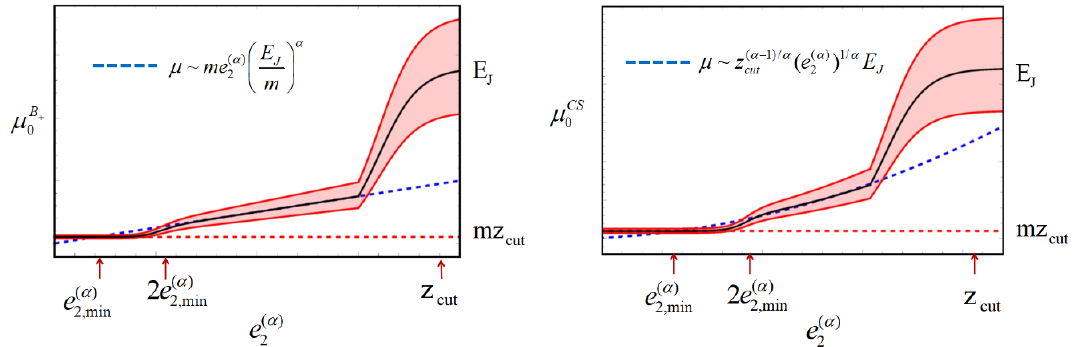
Figure 9 . Pro(cid:12)les in the renormalization scales for the bHQET jet (left) and the collinear-soft (right) functions. These two functions combine into a single one ( B SD a natural scale (cid:22) = mz (cid:22) = E J . The pink band indicates a scale variation by a factor of 2 above and below the central